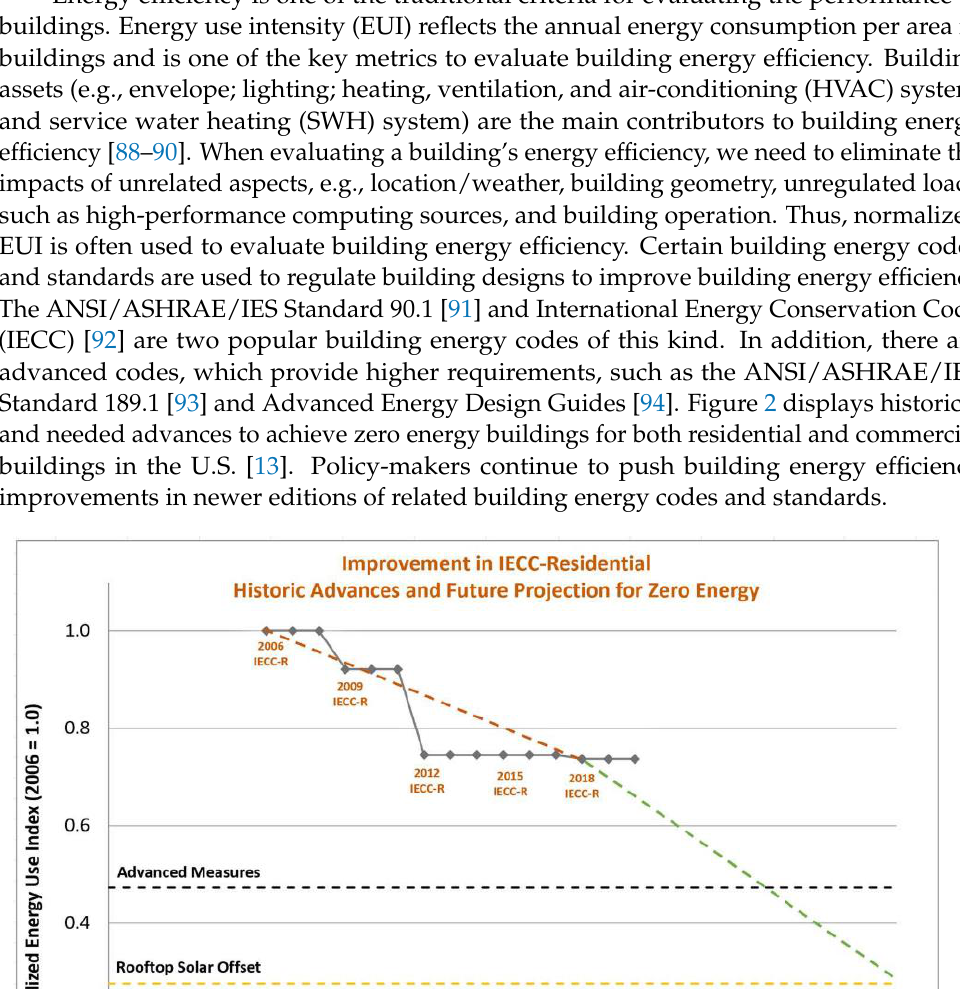
( b ) Commercial buildings Figure 2. Chronological estimate of the performance of various codes [13] . Reproduced with per- mission from Battelle Memorial Institute, 2022.